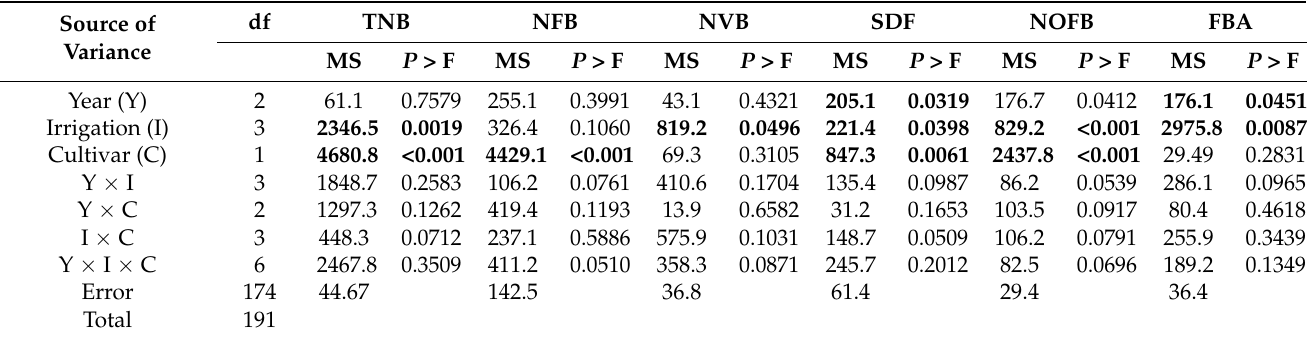
df: degree of freedom. MS: Mean squares. P > F: The probability values associated with the